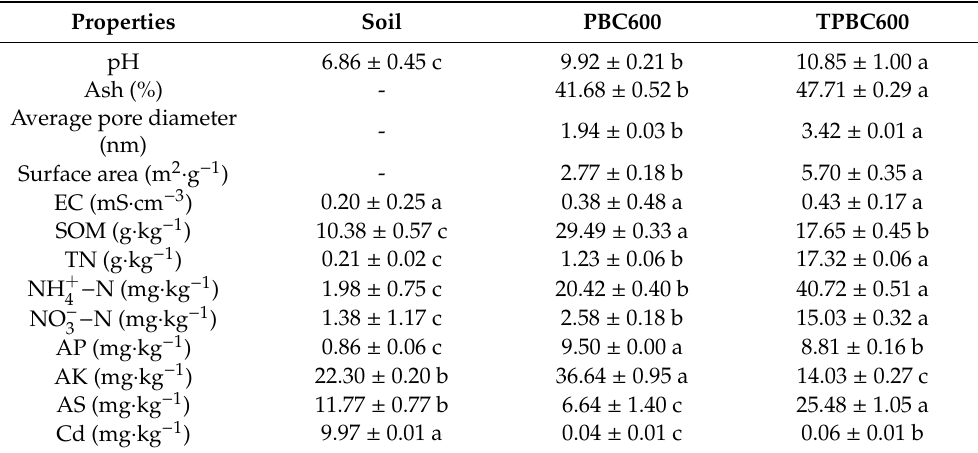
Table 1. Physical and chemical properties of soil and